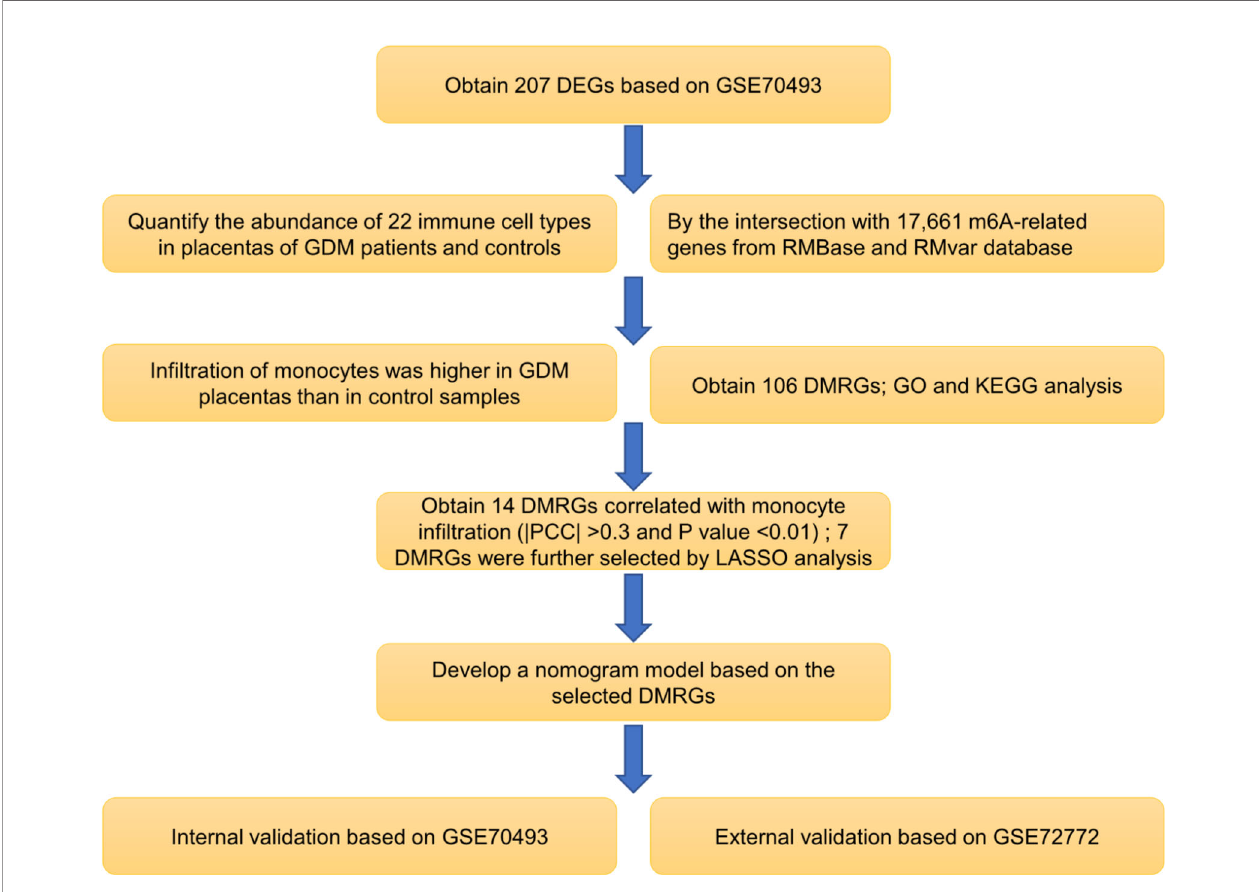
FIGURE 1 | Flowchart of the research work fl ow. Abbreviations are de fi ned as follows: differentially expressed gene (DEG), gestational diabetes mellitus (GDM), differentially expressed m6A-related gene (DMRG), Gene Ontology (GO), Kyoto Encyclopedia of Genes and Genomes (KEGG), Pearson correlation coef fi cient (PCC), least absolute shrinkage and selection operator